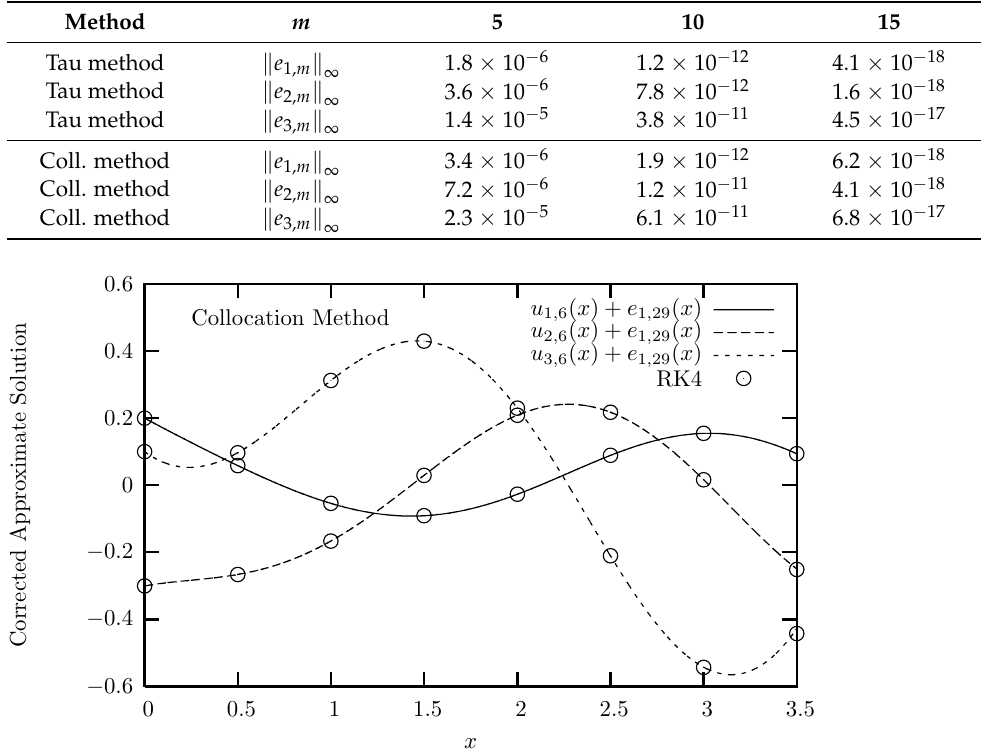
Figure 3. The corrected approximate solutions to Example 3 for m =